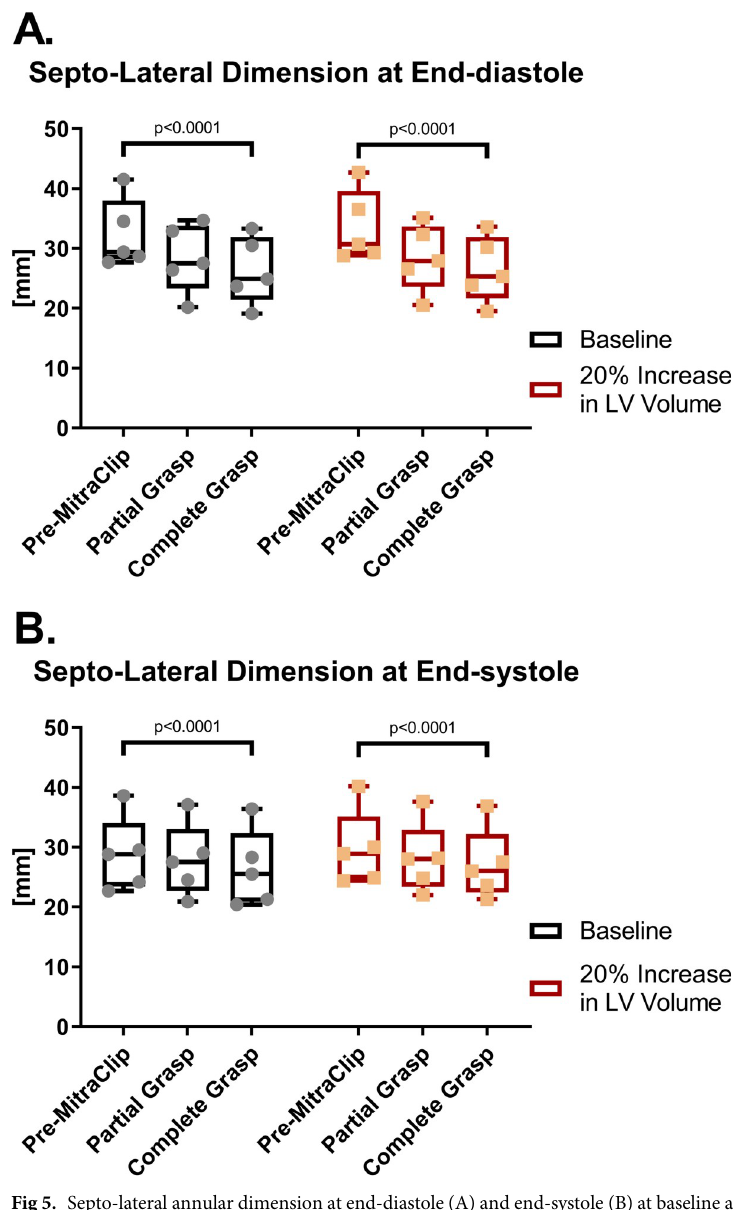
Fig 5. Septo-lateral annular dimension at end-diastole (A) and end-systole (B) at baseline and after simulated partial and complete grasp MitraClip.